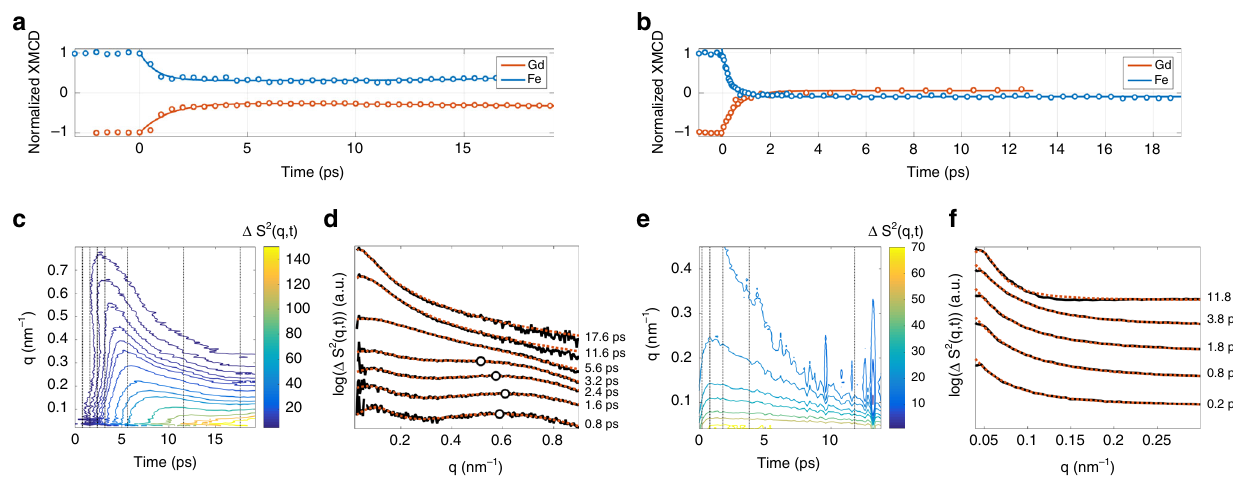
Fig. 3 Experimental XMCD and spin – spin correlation. XMCD data is shown in a non-AOS obtained in a 30 nm-thick sample subject to an absorbed fl uence of 3.91 mJ cm − 2 and b for AOS obtained in a 20 nm-thick sample subject to an absorbed fl uence of 4.39 mJ cm − 2 . Solid lines are guides to the eye. c Contours of the azimuthally averaged spin – spin correlation function, Δ S 2 ( q , t ), for non-AOS. For the time instances indicated by dotted vertical lines, lineouts are shown by black curves in ( d ) and are vertically shifted for clarity. Fits to the data with a Lorentzian line-shape for the low- q diffraction ring below q = 0.1 nm − 1 and a Gaussian line-shape for the high- q diffraction ring above q = 0.4 nm − 1 are shown by dashed red curves. The black circles indicate the fi tted ring radius of the Gaussian component. e Contours of the azimuthally averaged spin – spin correlation function, Δ S 2 ( q , t ), for AOS. For the time instances indicated by dotted vertical lines, lineouts are shown by black curves in ( f ) and are also vertically shifted for clarity. Fits to the data with a Lorentzian line-shape are shown by dashed red